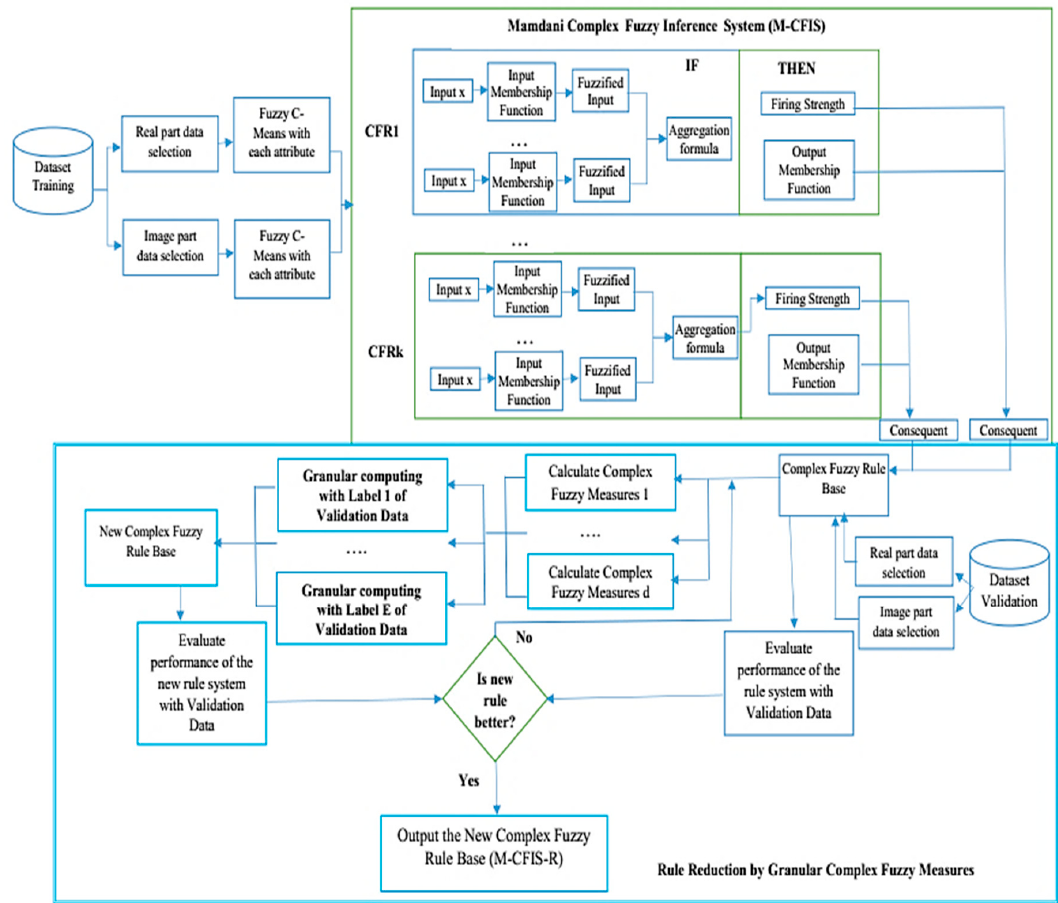
Figure 1. Training diagram for the proposed model.